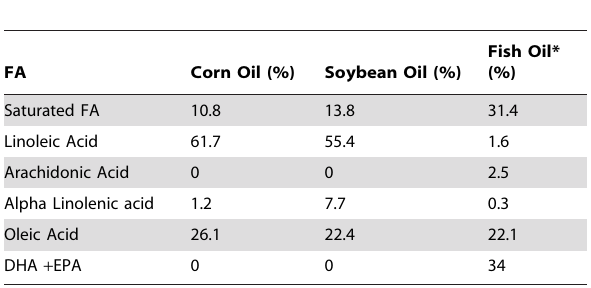
Table 1. Major fatty acid compositions of dietary oil used in preparing high-fat diets.